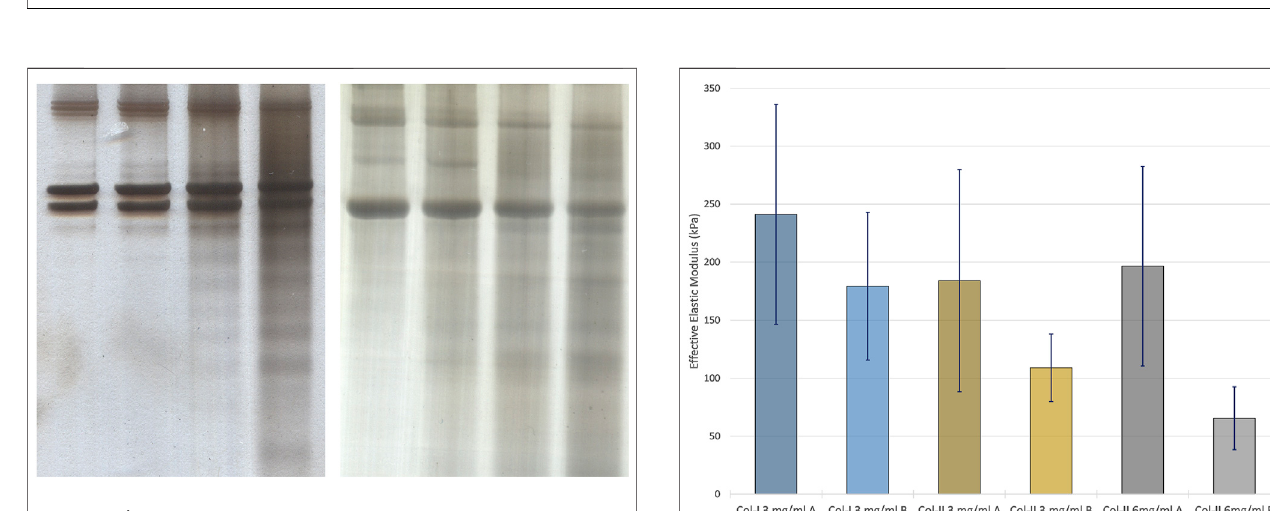
FIGURE 5 | Silver stained SDS-PAGE gels for detecting degradation of collagen of collagen type I (A) and collagen type II (B) from exposure to ultrasonicatomization.Ineachcasethelanesareinorderof(lefttoright)0,20, 60, and 120 min of exposure.